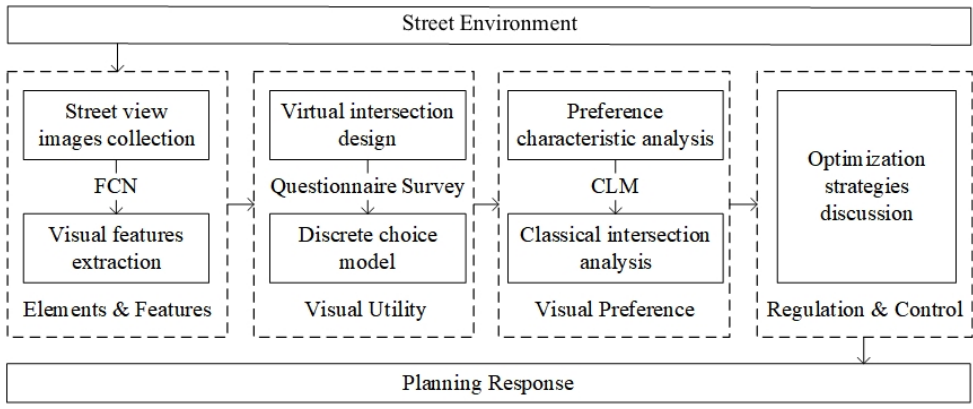
Figure 2. Research